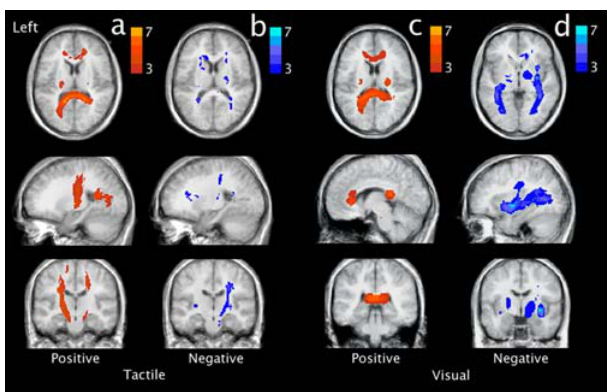
Figure 3. Accumulated group fDTI results for the tactile and visual task. For both tasks the accumulated group fDTI results were computed and overlaid on the subjects’ average anatomy. The color of the voxel represents the number of subjects for which active tracts are found at that position. Red voxels denote positively correlated activation (a,c) while blue voxels denote negatively correlated activation (b, d). Note that for the visual task the slices for the positively correlated activation (c) and negatively correlated activation (d) were taken at different positions. The results for the positively correlated activation showed that the majority of the positively correlated activation (c) was found for tracts that were part of the splenium. Negatively correlated activation (d) was found at the position that corresponded with the optic radiation.